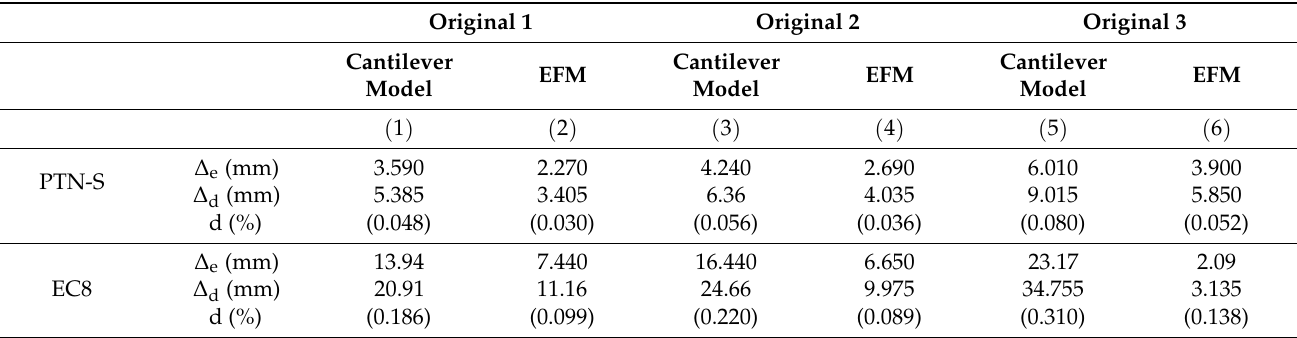
Table 10. Lateral displacements and total drift ratio for the original structure in N–S direction.